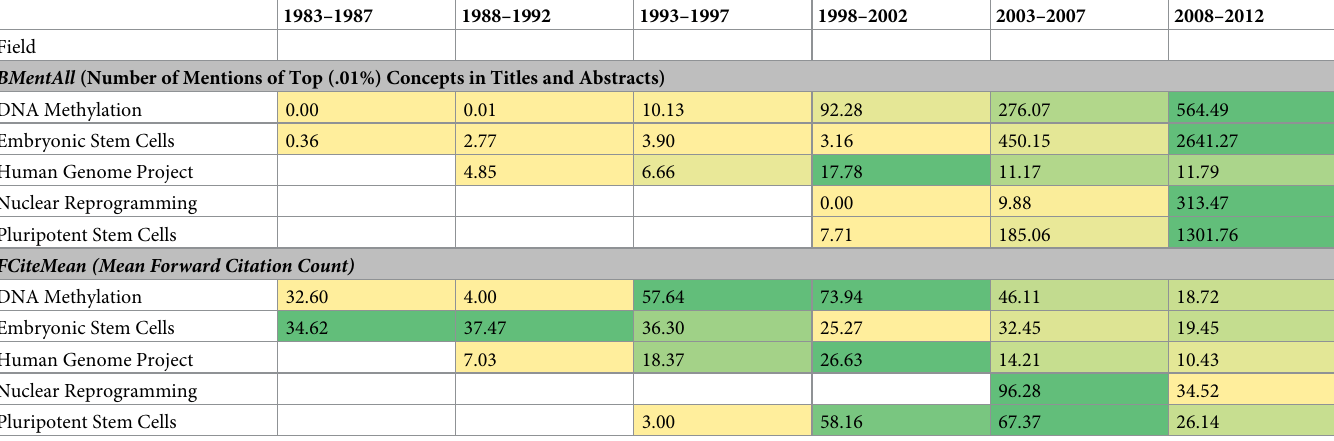
Table 2. Exemplary depiction of field-period